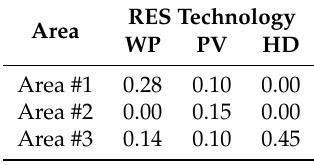
Table 1. CFs values.